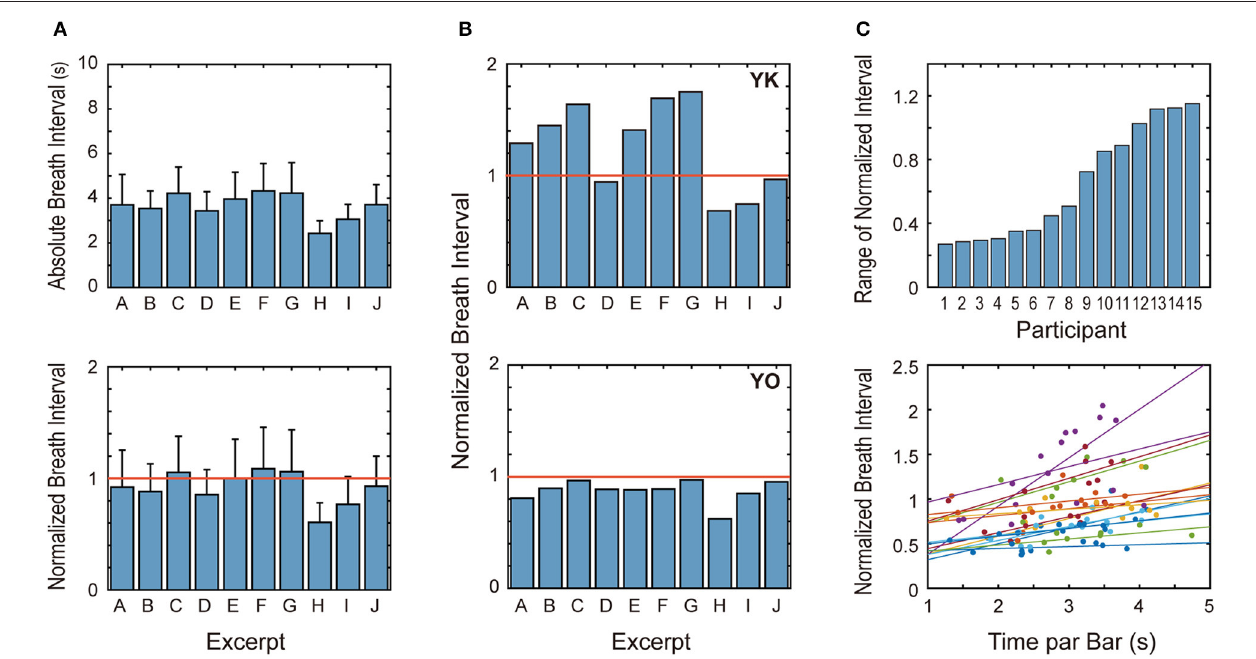
FIGURE 2 | Mean breath interval of different excerpts. (A) Inter-participant means of absolute breath intervals and normalized ones for different music excerpts are summarized. Breath intervals were significantly different between the excerpts. (B) Average breath intervals of two specific participants are shown. (C) The upper panel shows the difference between the maximum and minimum values of normalized breath intervals for 15 participants in a sorted manner. The lower panel is a scatter plot between “time per bar” and “normalized breath interval” for all participants. Each color represents one participant and the line having the same color is its regression line. All regression lines have positive slopes, indicating that the breath intervals became longer for the excerpts played in slower tempo.